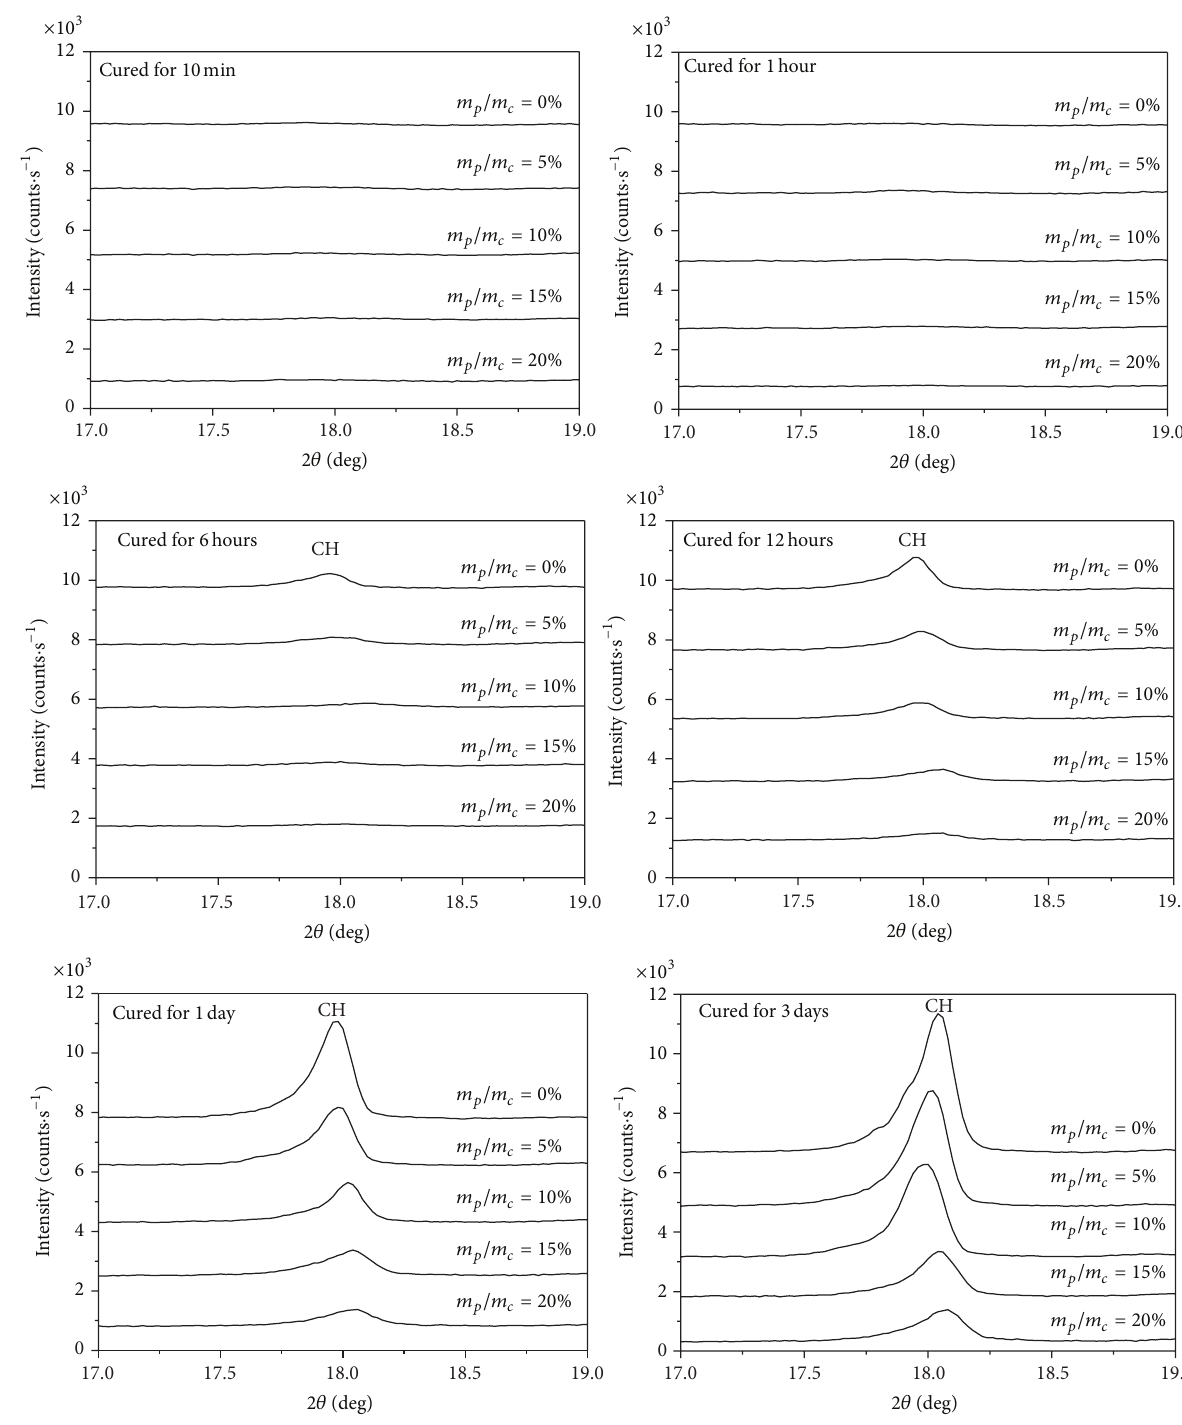
Figure 4: XRD patterns of cement pastes with SAE dispersion at 2𝜃 range of 17 ∘ –19 ∘ .